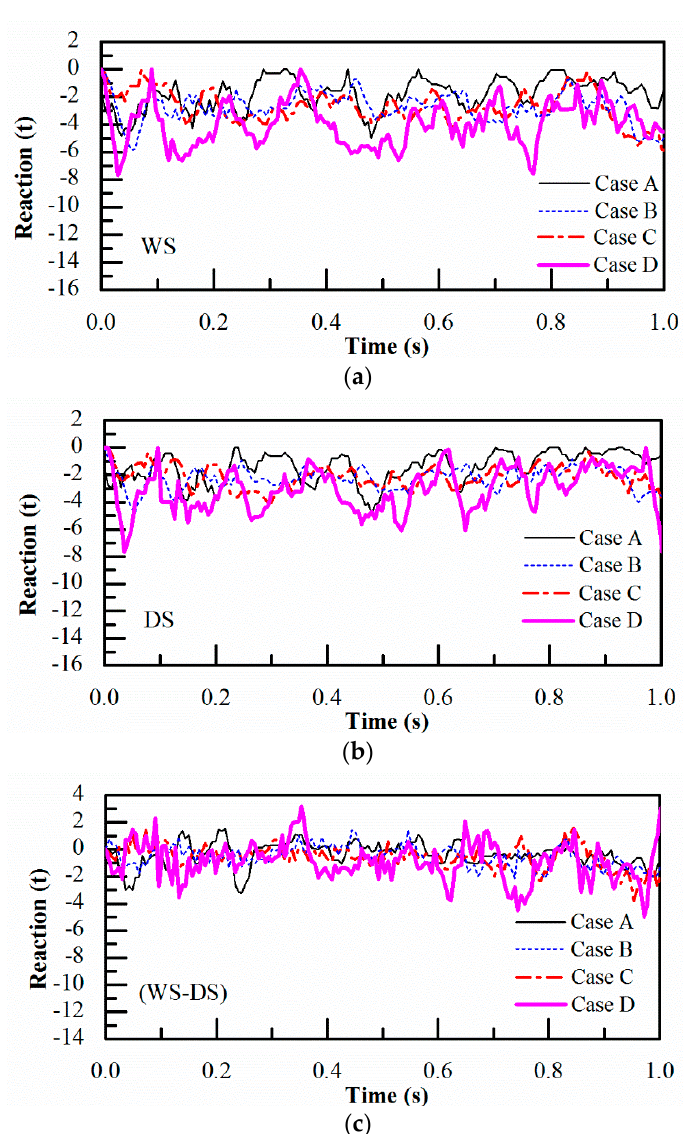
Figure 11. Comparison of reactions at chocks and housing resulting from different asymmetry of horizontal clearances of rolls. ( a ) WS, ( b ) DS, ( c ) difference between WS and DS.